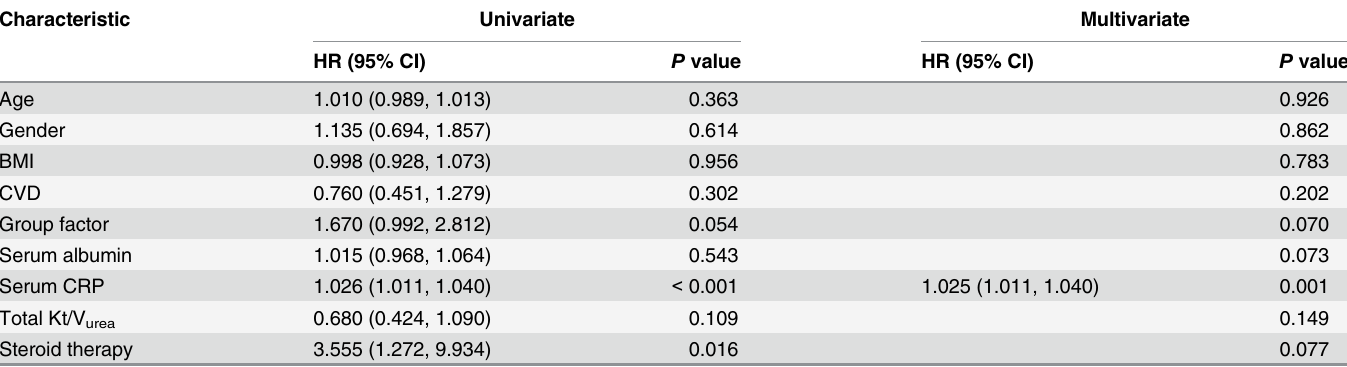
Table 7. Results of univariate and multivariate Cox analysis of peritonitis-free survival in all diabetic peritoneal dialysis (PD) patients.